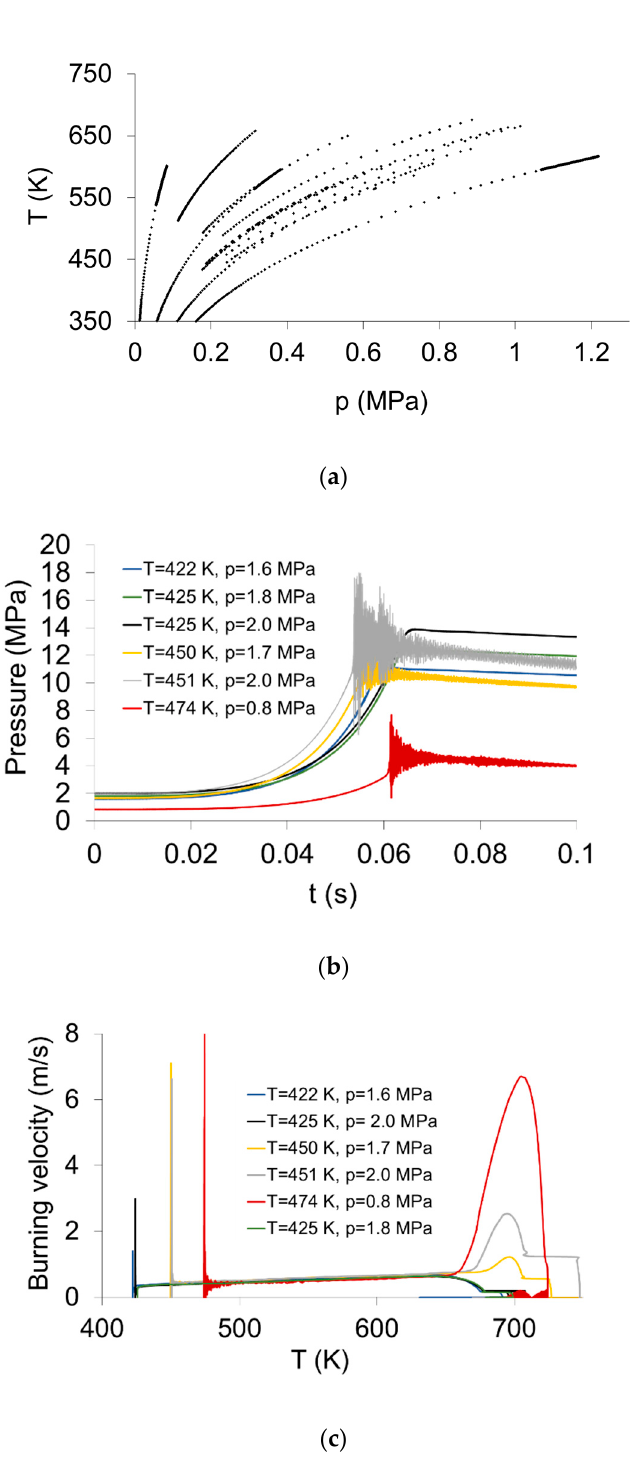
Figure 9. ( a ) Pressure–temperature diagram; ( b ) pressure; ( c ) burning velocity. Temperature–pressure map, the temporal evolution of pressure and burning velocity versus the unburned temperature for the combustions of n-heptane with a 0.9 of equivalence ratio.